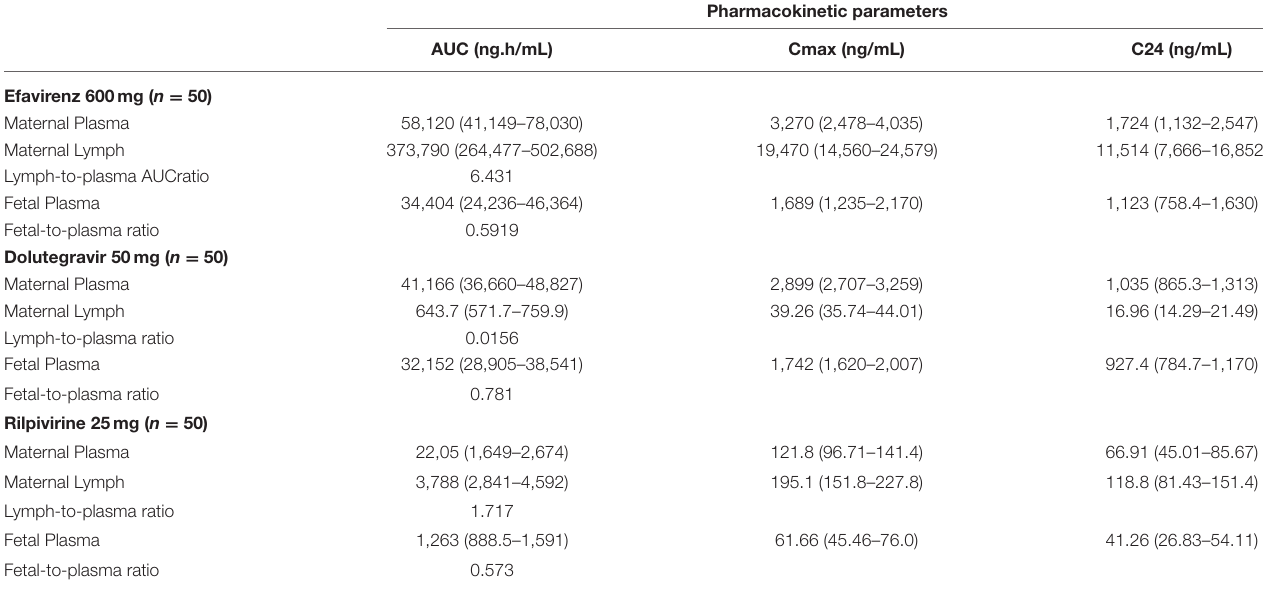
TABLE 5 | Predicted median (IQR) maternal plasma and lymph in third trimester; and fetal plasma pharmacokinetic parameters of efavirenz, dolutegravir and rilpivirine.